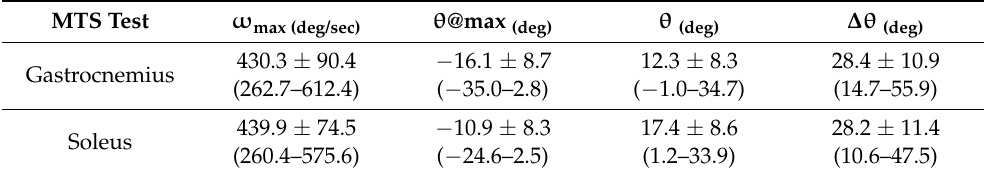
Table 2. Means ± standard deviation (range) of the maximum foot angular velocity ( ω max ), angle at maximum angular velocity ( θ @max), angle at maximum DF ( θ ), and the differences ( ∆ θ ) between θ @max and θ from during Gastrocnemius and Soleus Tardieu tests